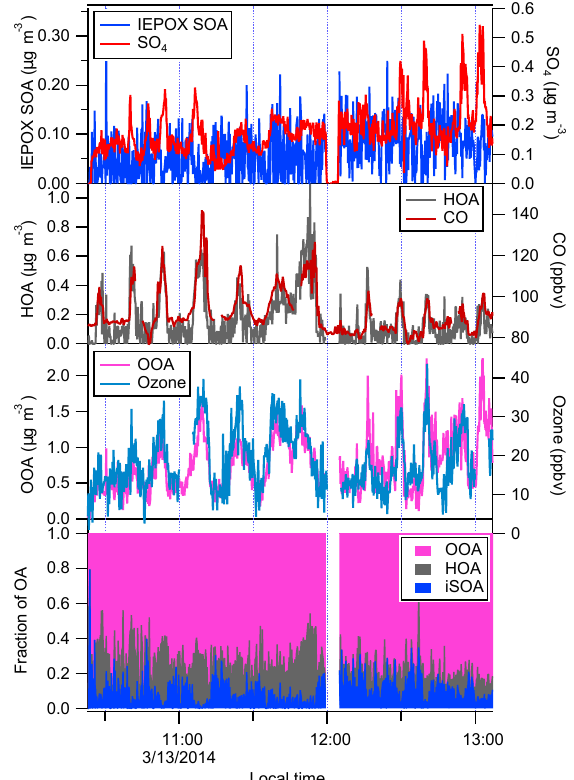
Figure 6. PMF analysis of the organic aerosol on the 13 March 2014 flight. AMS data are normalized to 23 ◦ C and